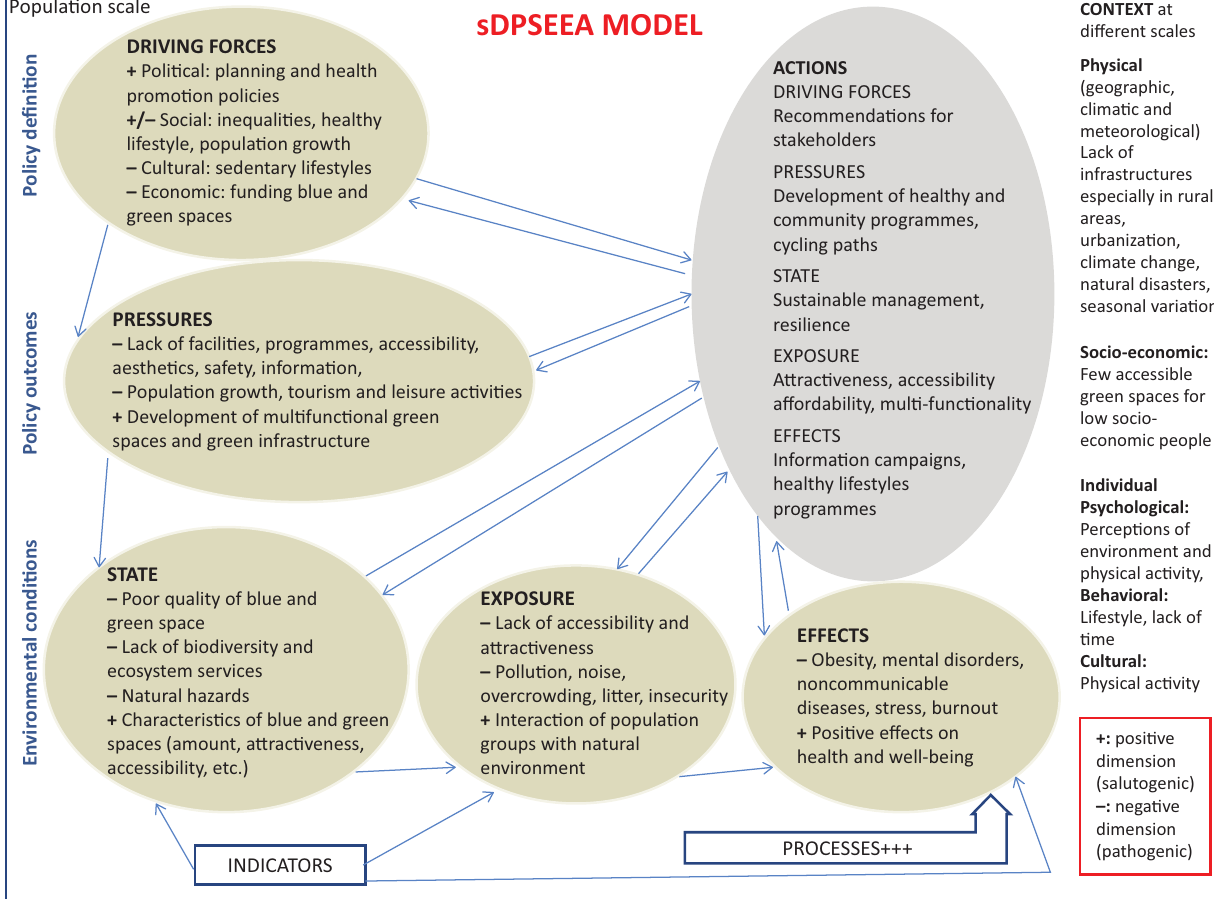
Figure 2. The sDPSEEA model proposed to incorporate systemic thinking for policymakers and practitioners concerned with identifying and monitoring the impacts of interventions on public health such as the provision of public green